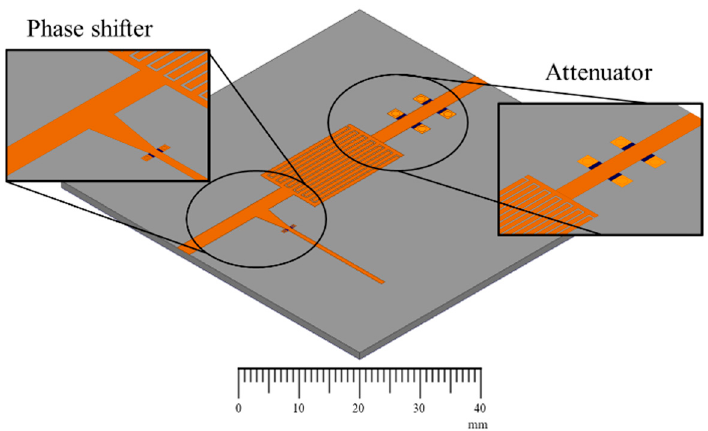
Figure 1. Prototype of the amplitude-phase variation transmission line. In the insets, the black spots are graphene depositions next to grounded vias.